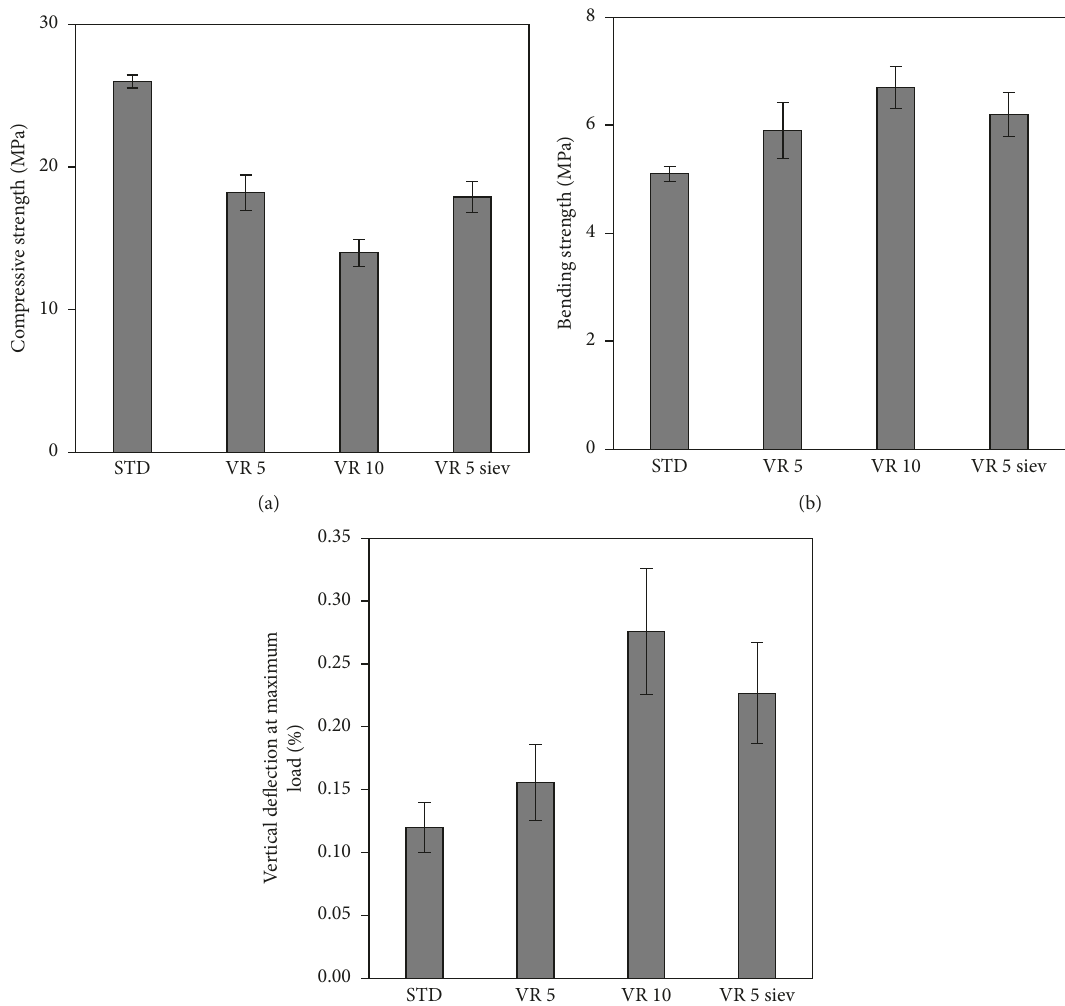
Figure 7: Compressive strength (a), bending strength (b), and vertical deflection at maximum load (c) of